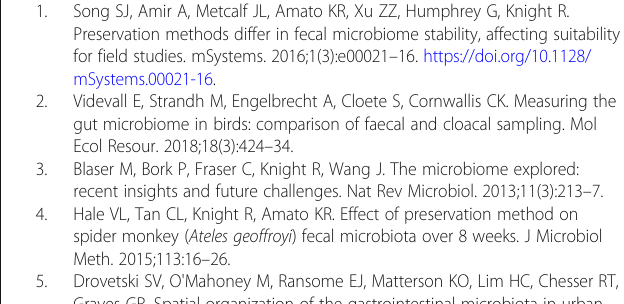
Additional file 1: Table S1. OTU table of all samples, categorized according to the sample region and preservation method (freshly dissected, two-weeks old and two-month alcohol specimens). Additional file 2: Table S2. Results of pairwiseAdonis analysis between gut microbial communities of major gut regions [the stomach, the midgut (the small intestine and the cecum), and the hindgut (large intestine and cloaca)] and cloacal swabs. Asterisks indicate sections that were significantly different in composition. Table S3. The results of pairwiseAdonis analyses using Jaccard distances between gut microbial communities of different regions of the digestive tract (including cloacal swabs). Table S4. Summary of one-way analysis of variance (ANOVA)